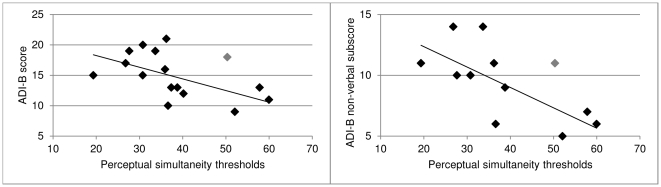
Correlation of thresholds with symptoms.ADI-B scores (left) and non-verbal ADI-B sub-score only (right) in the ASD group over perceptual simultaneity thresholds. The data point corresponding to the threshold derived from a curve fit with a goodness of fit R2>90 is depicted in grey. Note that there are two overlapping data points (31, 10).